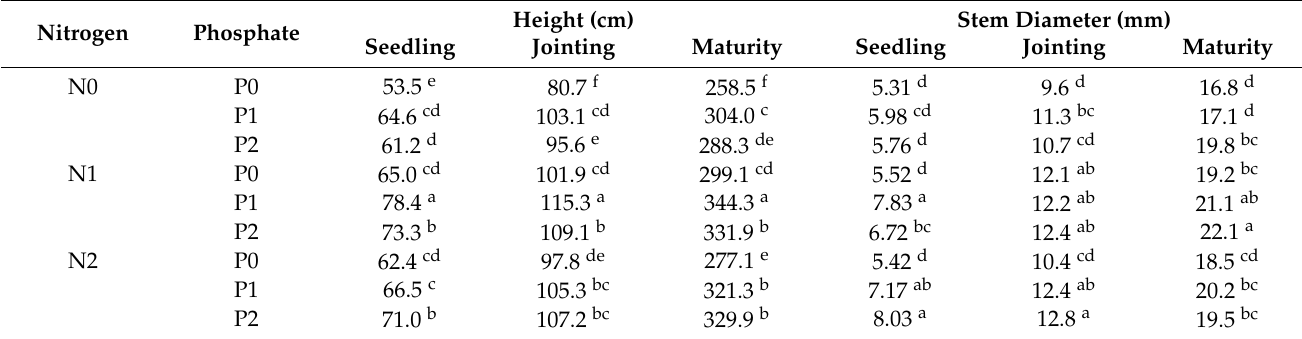
Table 1. Effects of nitrogen and phosphorus on plant height and stem diameter of sorghum plants grown in saline soils at the three growing stages of seedling, jointing, and maturity.